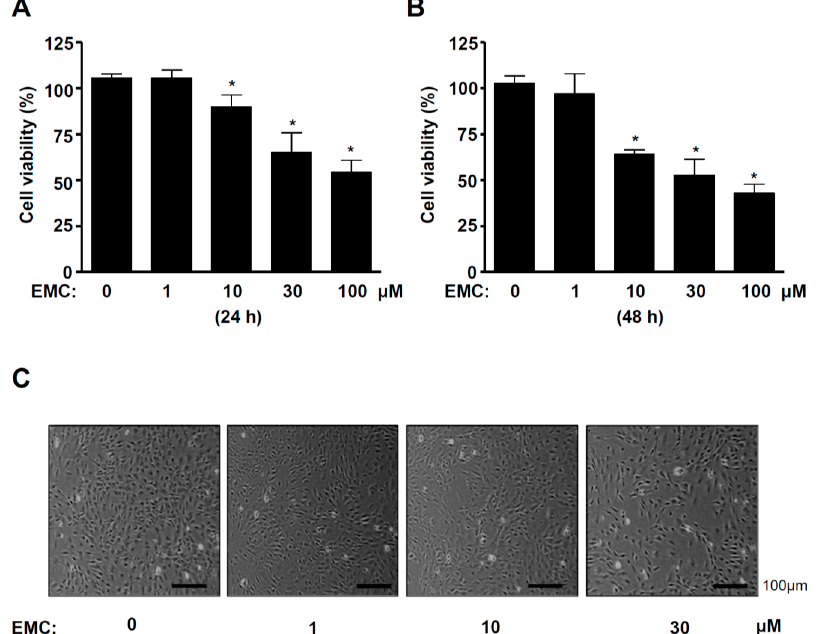
Figure 2. EMC decreases cell survival and induces morphological changes in pre-osteoblasts. ( A , B ) Pre-osteoblasts were treated with EMC (1, 10, 30, and 100 µ M) for 24 h ( A ) and 48 h ( B ). Then, cell viability was measured by the MTT assay. ( C ) The morphological changes were observed under the phase contrast microscopy after treatment with EMC for 48 h. The data are expressed as the mean ± S.E.M. of experiments. * ( p < 0.05) indicates statistically significant di ff erences compared to the control.